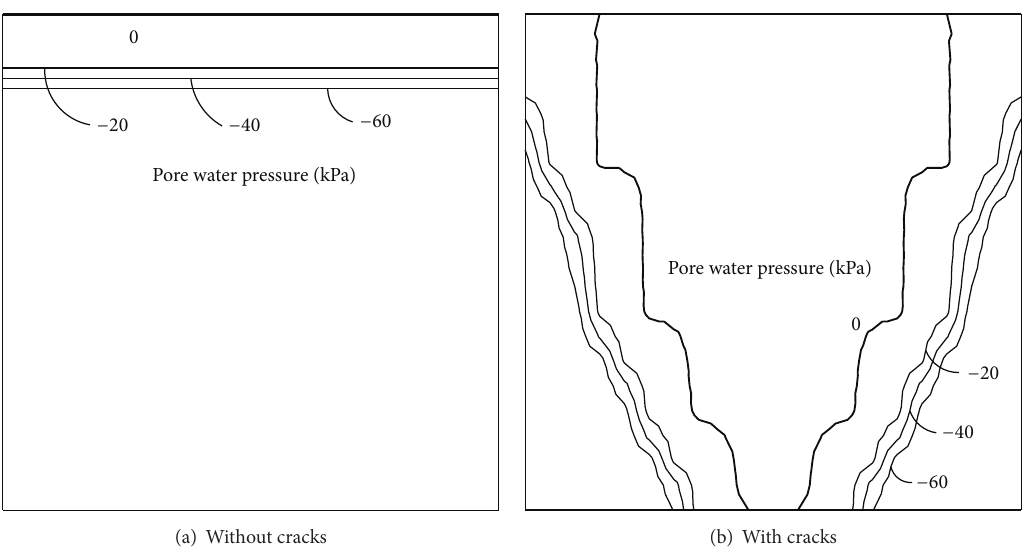
Figure 11: Pore water pressure contours after 5 minutes without or with